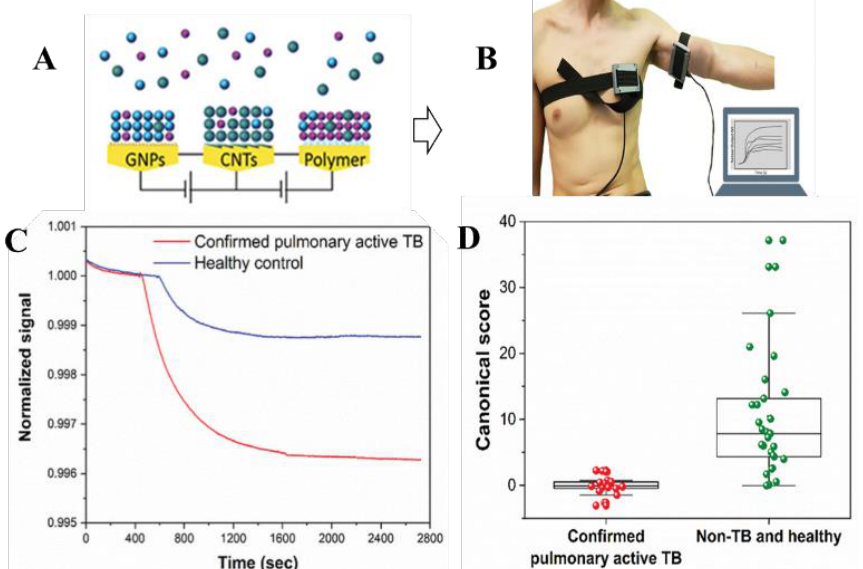
Figure 3. VOCs sensor for tuberculosis detection. ( A ) Nanoparticle modified sensor array; ( B ) Wear- able devices on the chest and anterior arm of a volunteer for VOCs measurement; ( C ) Normalized signals of the wearable device attached to the anterior arm area; ( D ) Use of Discriminant Function Analysis (DFA) based pattern recognition to distinguish between healthy and diseased samples. Reproduced with permission from Vishinkin et al. © 2022 Wiley (under Creative Commons CC BY